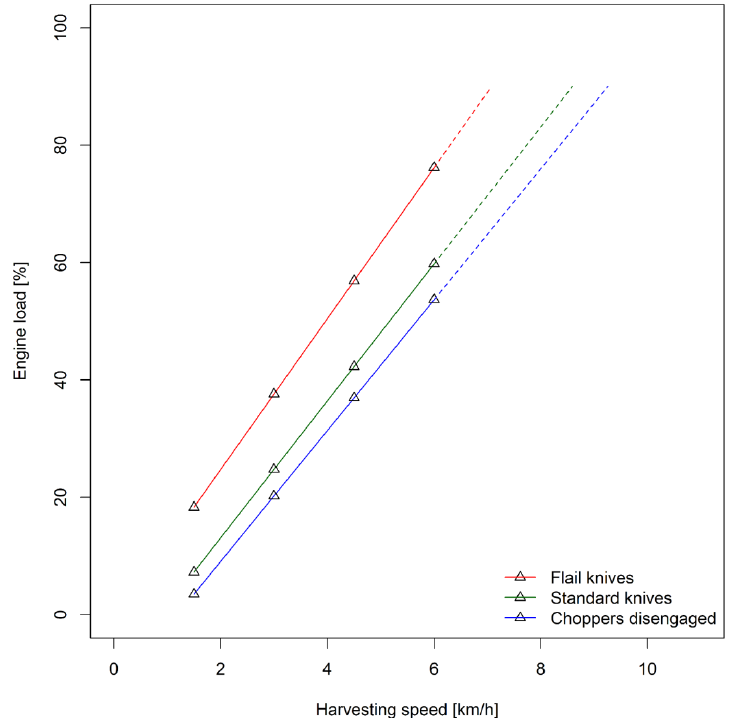
Figure A7. Percentage engine load of the combine harvester depending on harvesting speed for the levels of corn header configuration at cutting height level 3 (Markers indicate harvesting speed levels at cutting height level 3, dashed lines represent extrapolation up to a theoretical engine load of 90%).